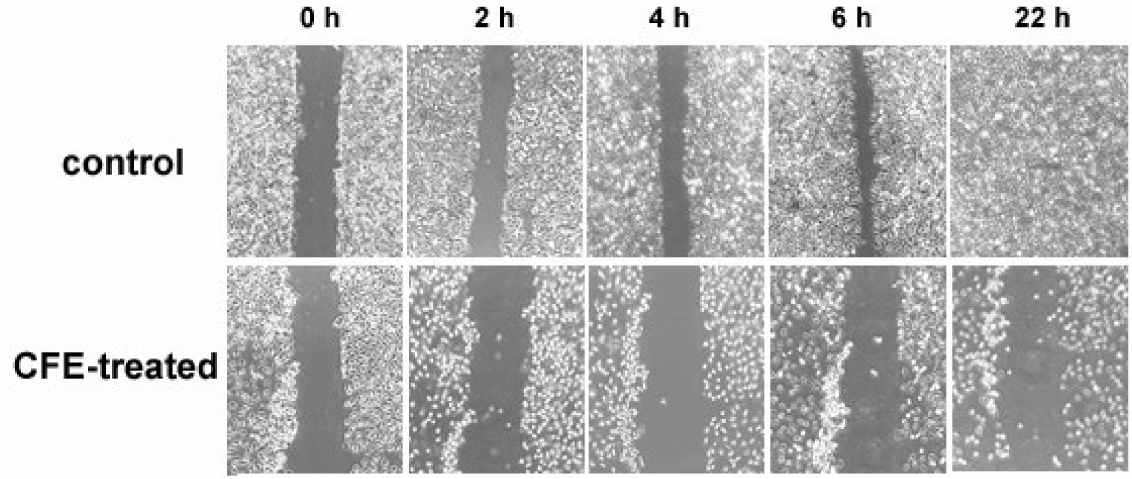
Figure 10. Panel of representative phase-contrast micrographs acquired during the wound healing assays at different time points under control conditions and in the presence of IC 50 24 CFE. The assay was performed in triplicate. Microscopical magnification = 20 ×